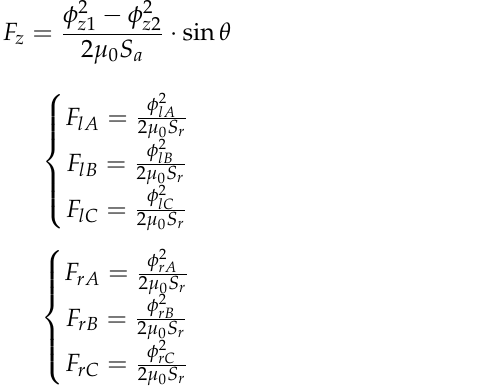
Table 1. Main design parameters.